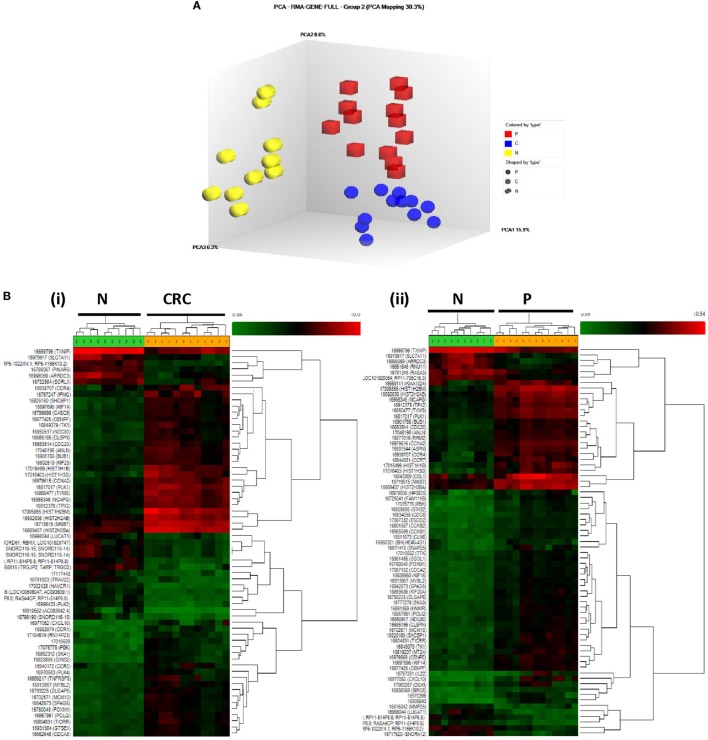
(A) Principal component analysis of CRC (blue), P (red), and N (yellow)-derived Tregs. The three Treg populations were clearly segregated. (B) Hierarchical clustering of (i) CRC- vs. N-derived Tregs and (ii) P- vs. N-derived Tregs. The one-way ANOVA analysis with false discovery rate correction (p < 0.01), log2 fold change (>2 or <−2) were considered as upregulated and downregulated genes, respectively.